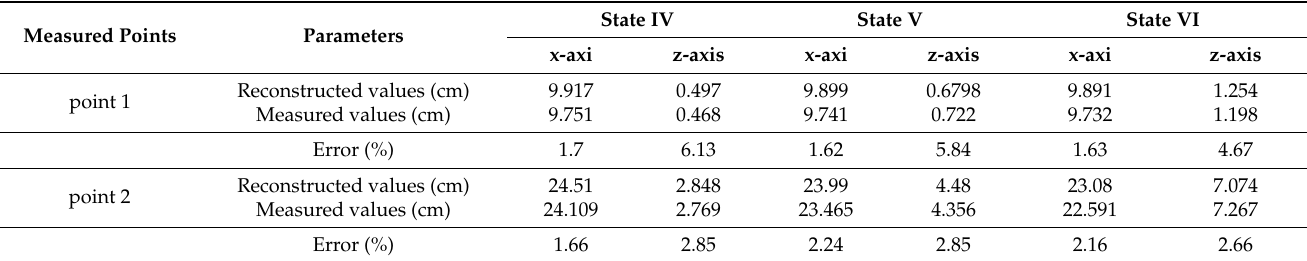
Figure 22. Test piece shape reconstruction loaded in both side points: ( a ) Initial state, ( b ) state IV, ( c ) state V, ( d ) state VI. Table 12. Comparison of the results of the measurement points in Figure